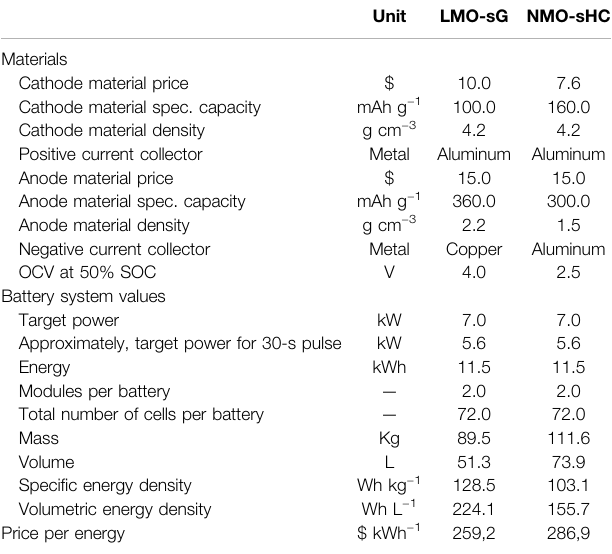
TABLE 2 | Total system cost ($ kWh − 1 ) of layered oxide cathode based LIBs and SIBs for 11 kWh systems (Vaalma et al., 2018).